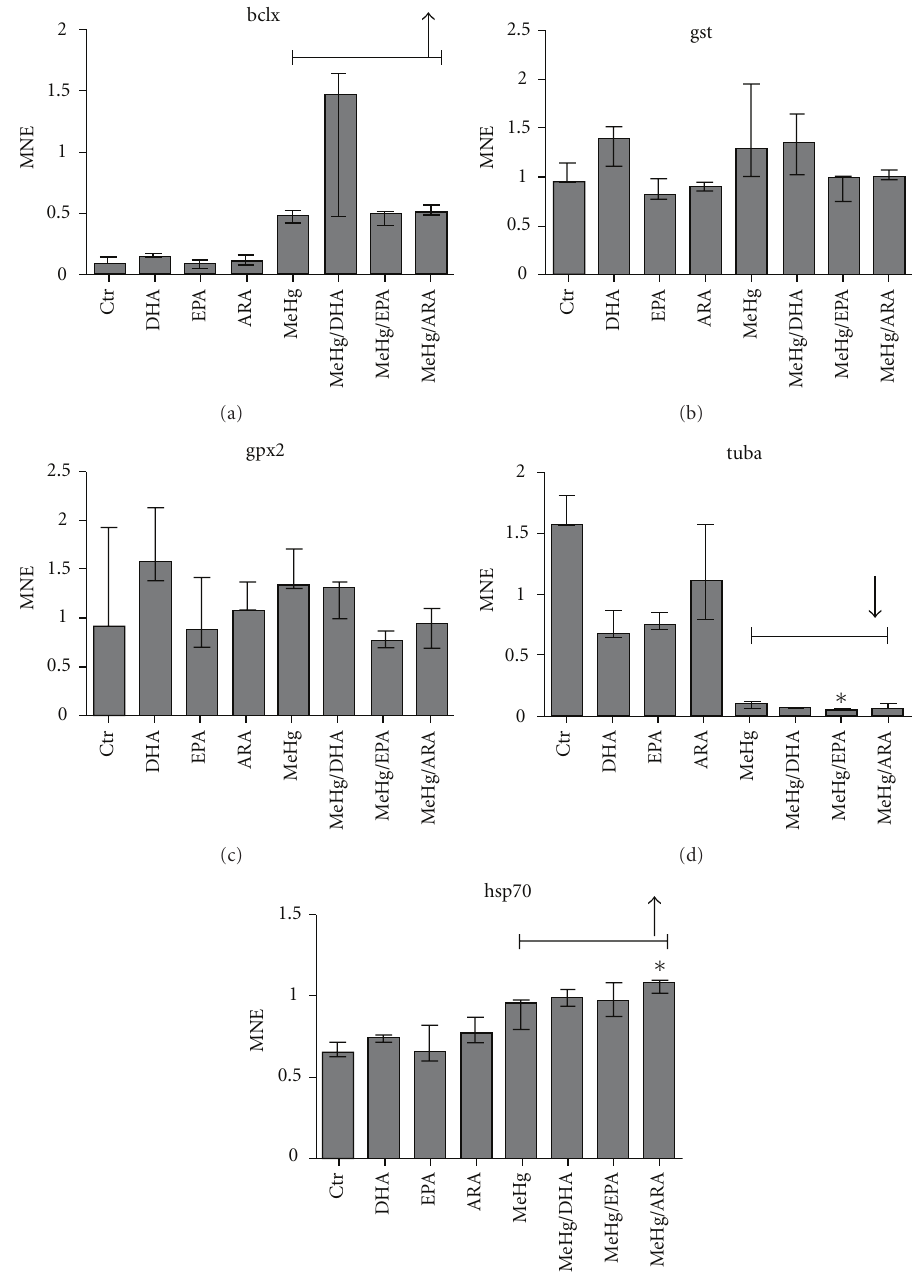
Figure 5: Mean-normalized expression (MNE) of (a) bclx, (b) gst, (c) gpx2, (d) tuba, and (e) hsp70 in ASK cells. Data are represented by median, with error bars representing interquartile range. Data are treated through factorial design, where n = 3 for all groups (columns shown), and significant di ff erences ( P ≤ 0 . 05) are indicated by asterix. MeHg and FA e ff ects were calculated across groups where n = 12 and n = 6, respectively. Significant e ff ects ( P ≤ 0 . 05) of MeHg are shown using bracket lines. No fatty acid e ff ect compared to control was observed. Statistical analysis was performed using nonparametric Kruskal Willis with post hoc paired